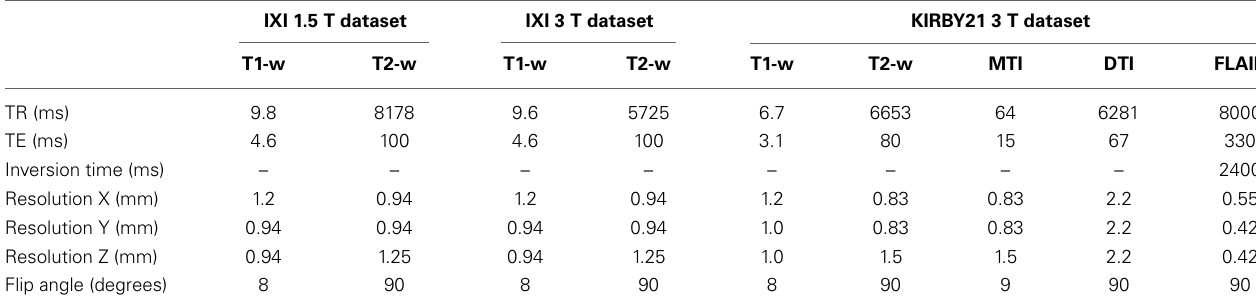
Table 2 | MR imaging sequence